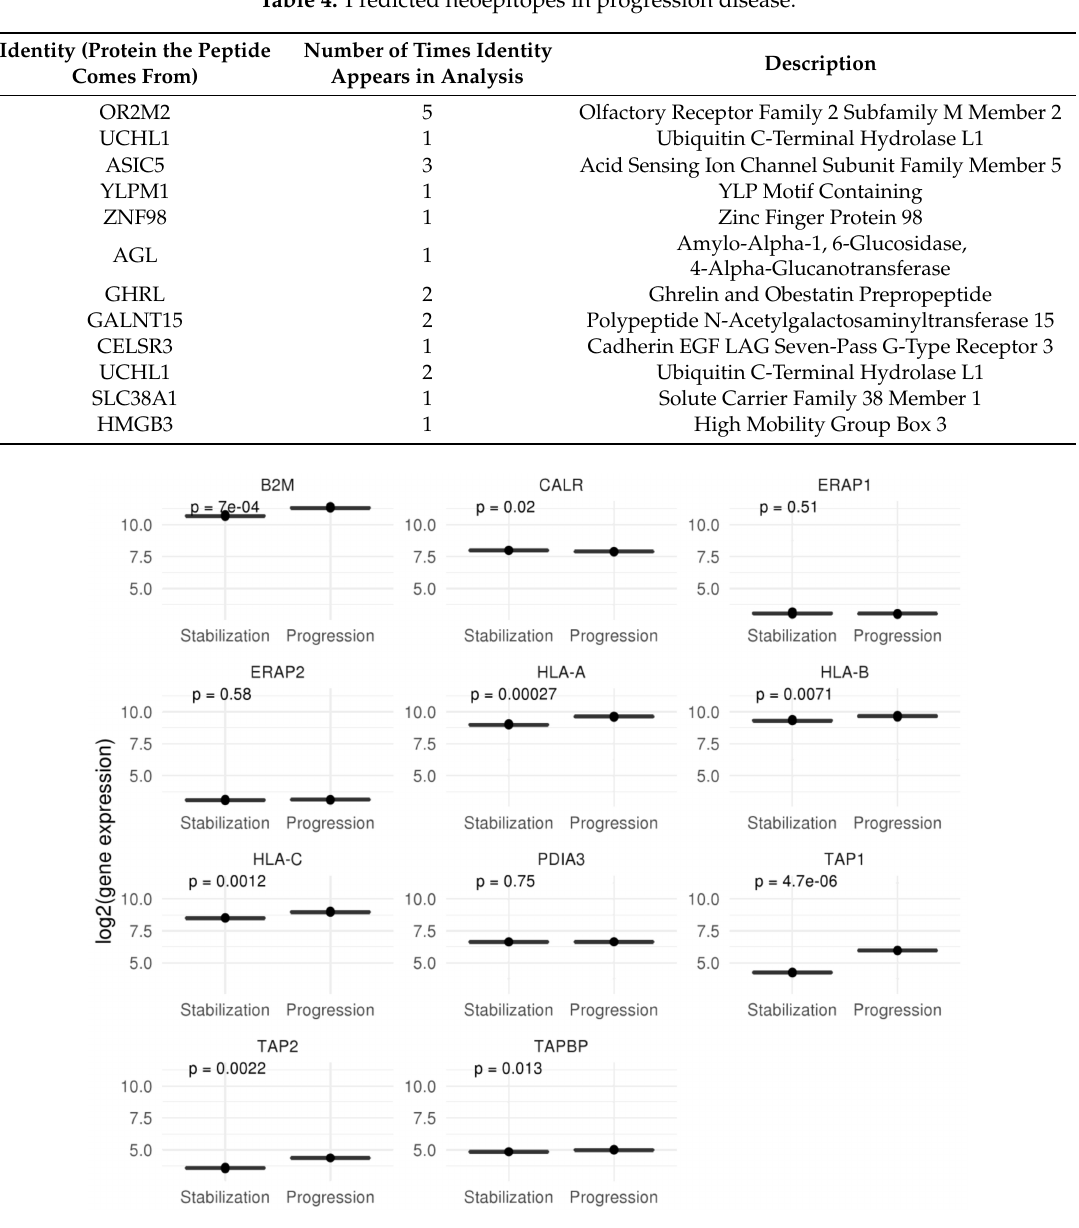
Figure 6. Gene expression of molecules related to antigen presentation and processing, including HLA